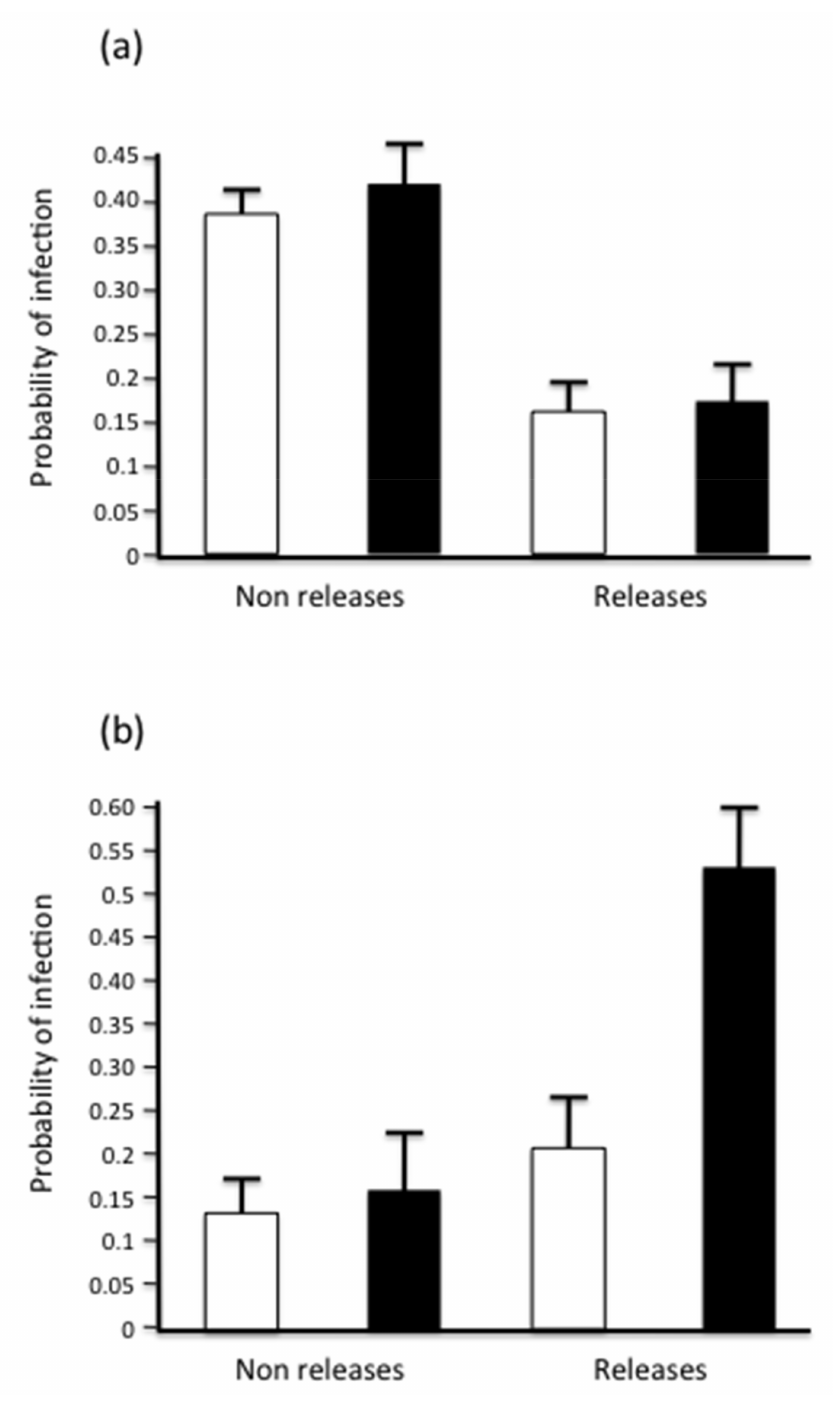
Figure 4. Probability of infection in red-legged partridges in game estates with releases and without releases with avian malaria parasites belonging to ( a ) Group A or ( b ) Group B of parasites, according to Figure 2. We show the weighted marginal means ( ± S.E.) during both spring (white bars) and autumn (black bars) sampling